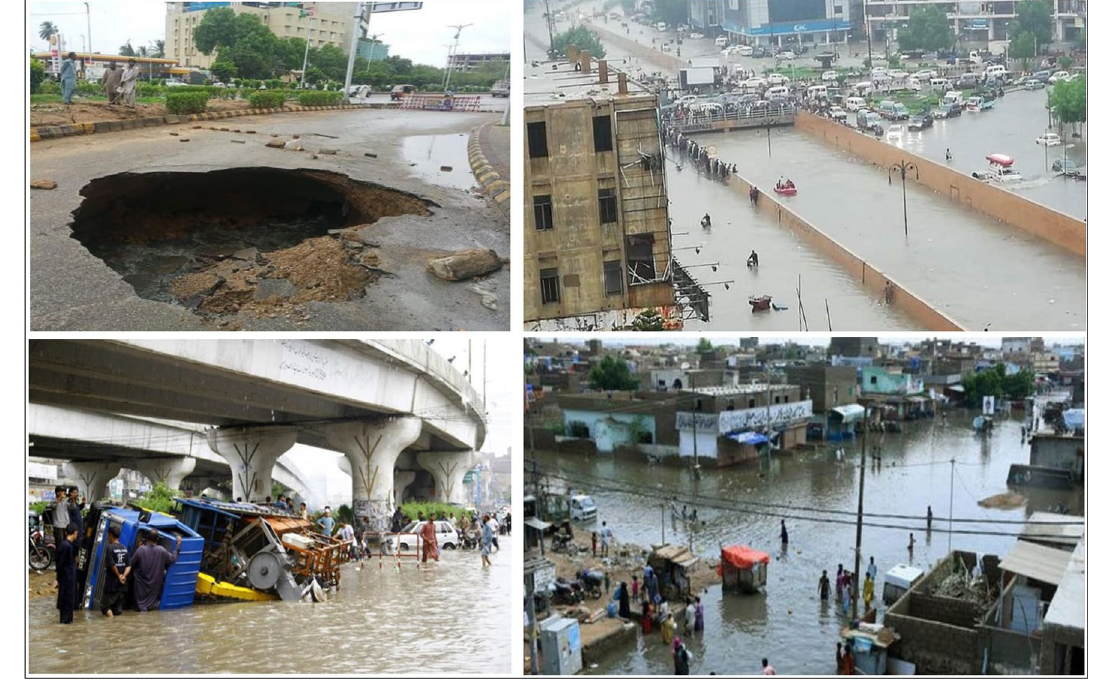
Figure 15. Water on the roads in Karachi city during